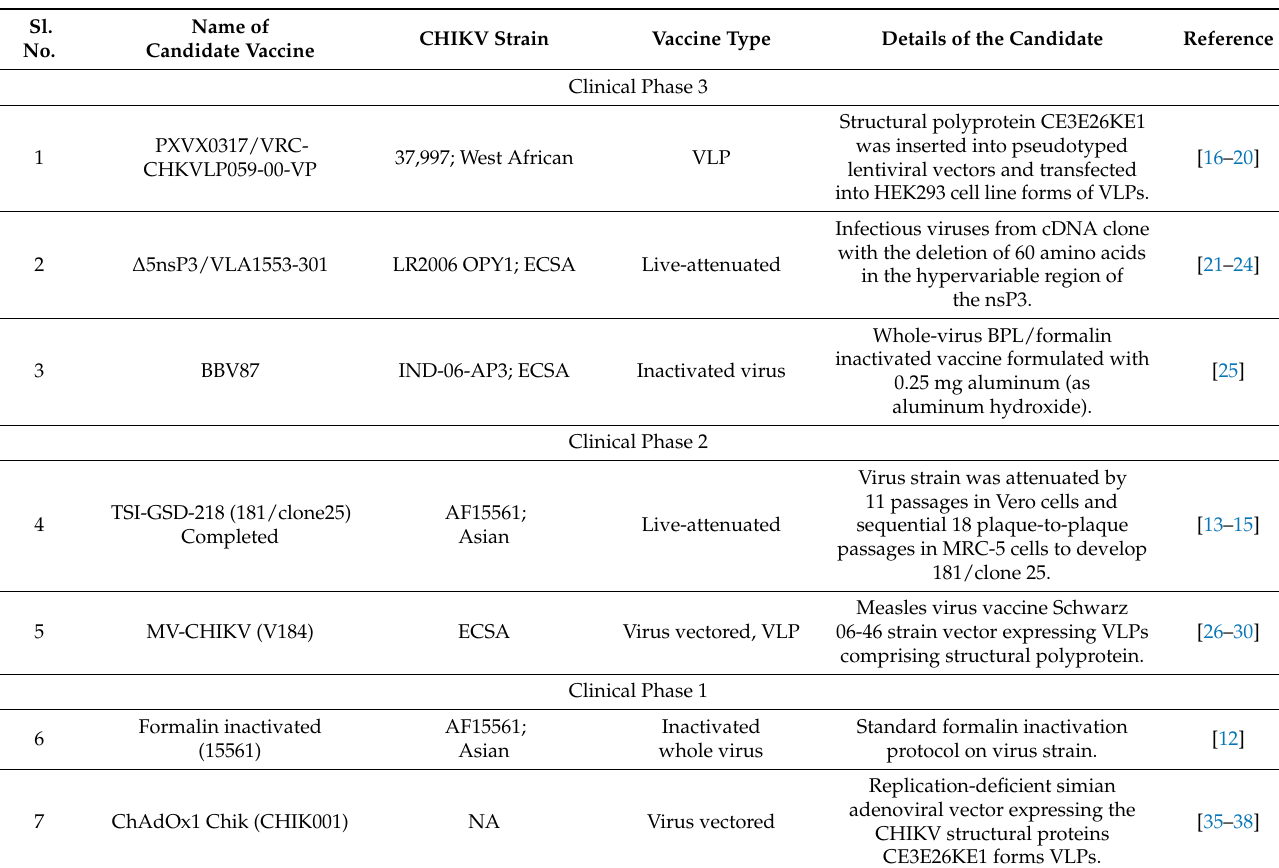
Table 1. Current chikungunya vaccine